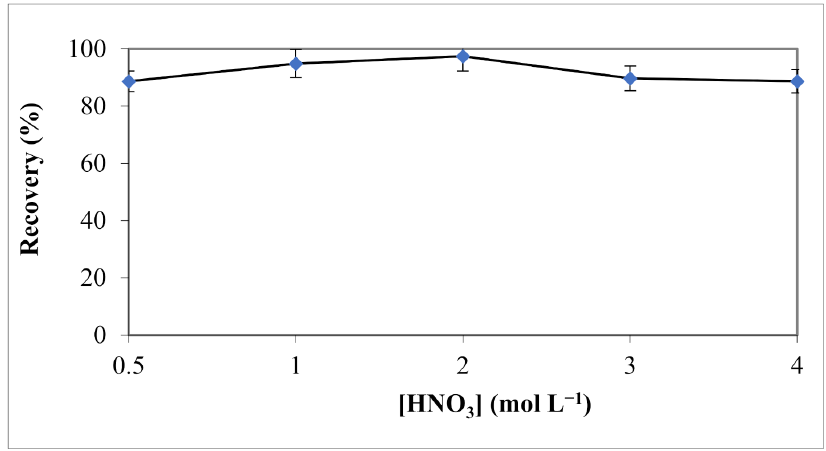
Figure 6. Effect of HNO 3 concentration on Cu (II) extraction (solvent volume = 12 mL).